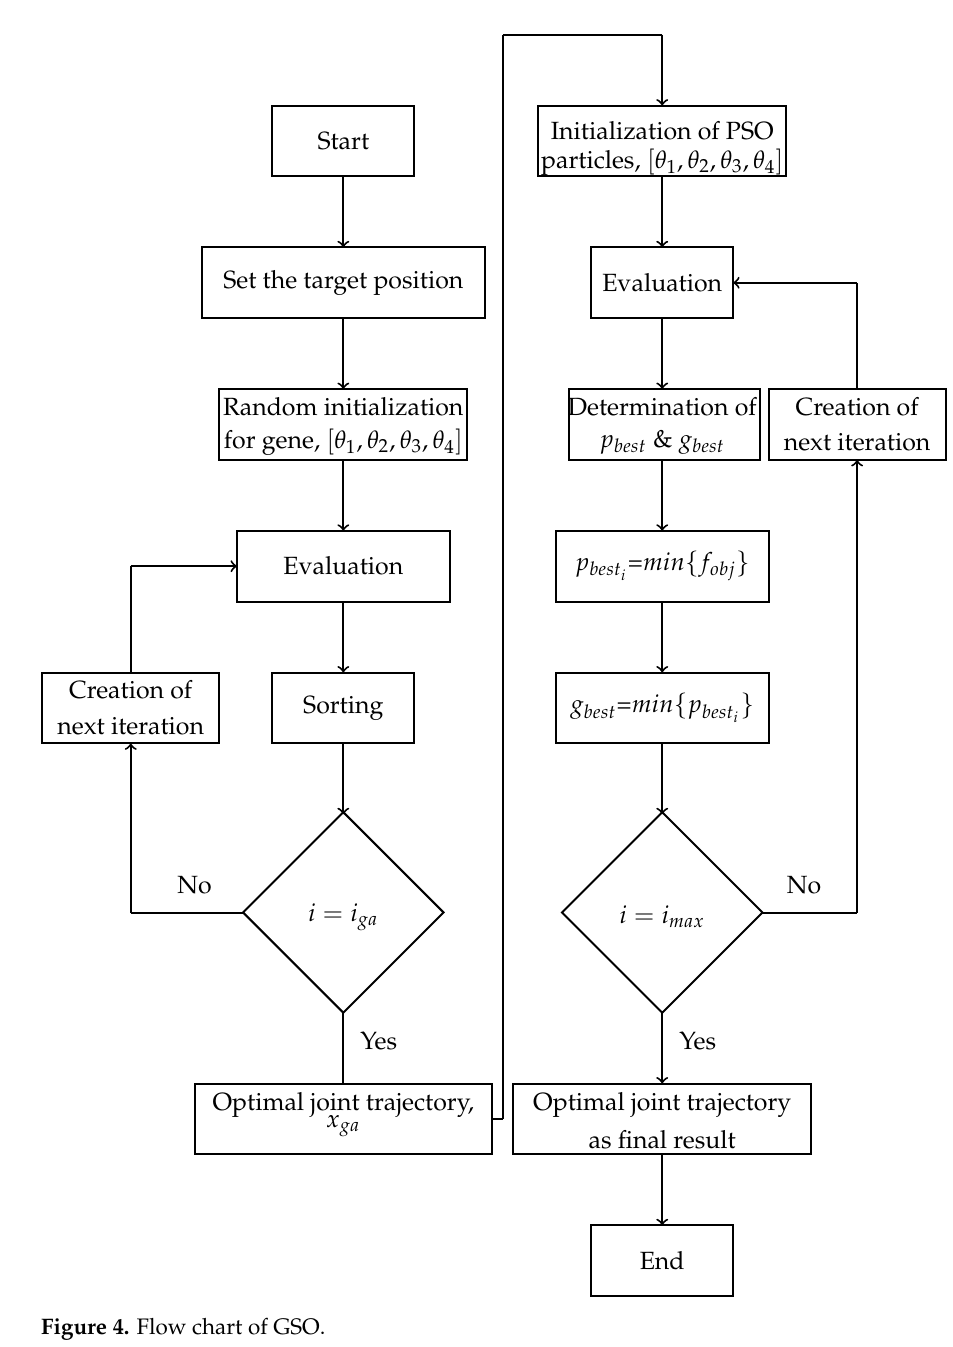
Figure 4. Flow chart of